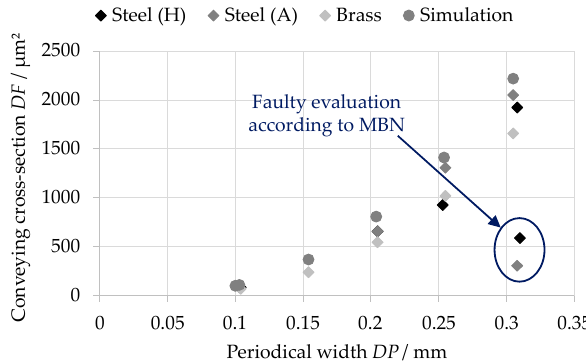
Figure 10. Relationship between periodical width and conveying cross-section of the experimental as well as the simulated data.